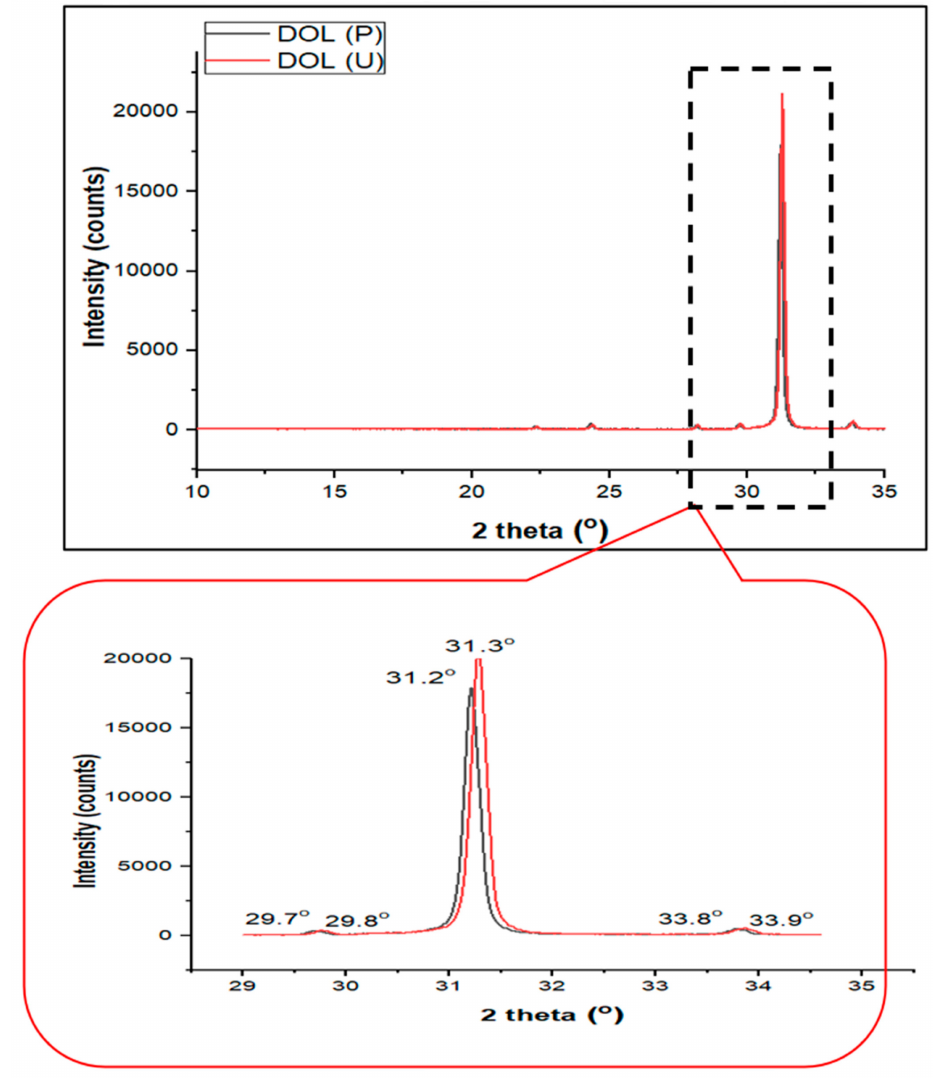
Figure 8. X-ray diffraction (XRD) pattern of DOL(P) and DOL(U). The XRD pattern of dolomite (DOL(P) and DOL(U)) reveals diffraction peaks at around 2 θ = 31.2 ◦ and 33.8 ◦ , which are similar to that observed by Mohammed et al. [15]. However, when benchmarked with the DOL(P), the DOL(U) shows more intense diffraction peaks at both angles. This signifies that the crystallinity of dolomite was enhanced by the sonication process. To prove this, the degree of crystallinity of both types of dolomite was measured and tabulated in Table 3. The degree of crystallinity for DOL(P) and DOL(U) was found to be 76.57% and 77.10%, respectively. The higher degree of crystallinity of the DOL(U) could be as a result of the 2-h sonication process. The reduction in particle size of dolomite has increased its surface area. As a result, signals from X-ray diffraction that went through the crystalline lattices of dolomite particles became stronger